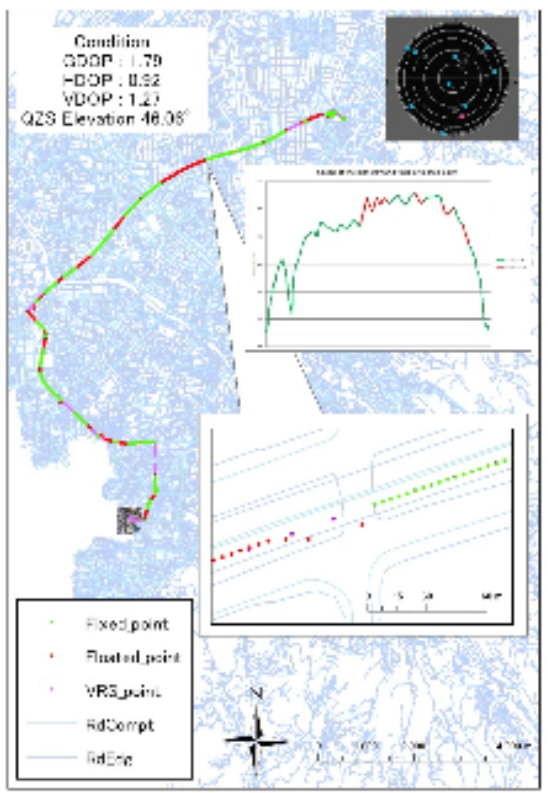
Figure 10. Observation result on the fundamental